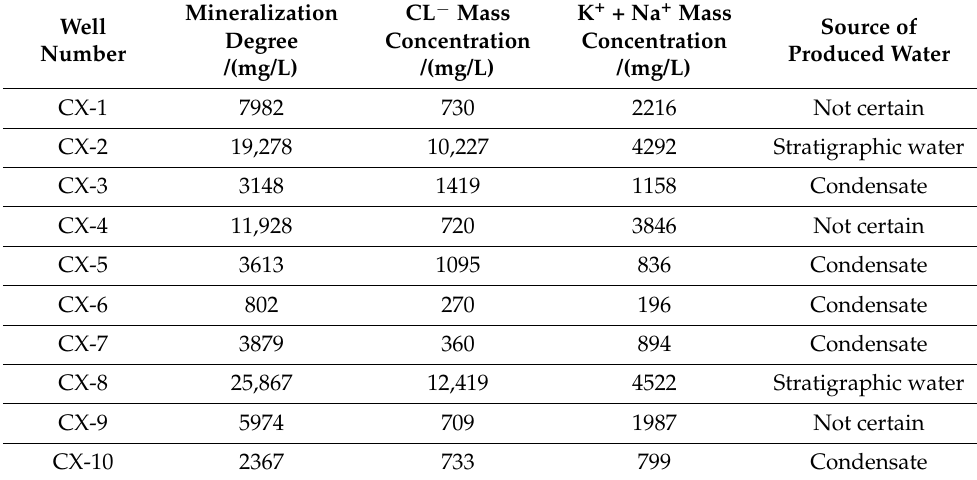
Table 2. Aqueous parameters of gas-well-produced